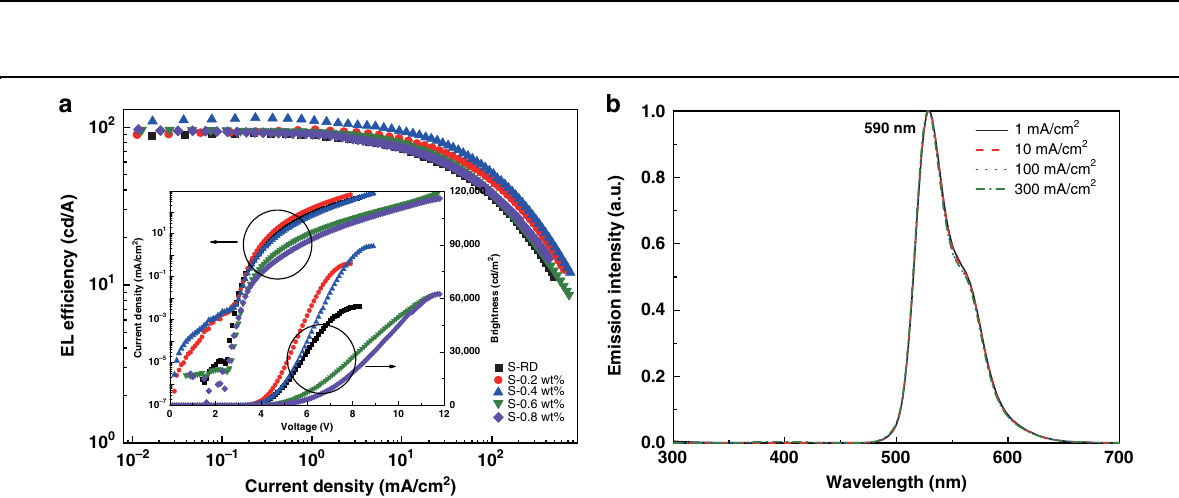
Fig. 12 The EL characteristics of Ir(tfmppy) 2 (tpip based devices at different co-doped concentrations. a Ef fi ciency – current density ( η – J ) characteristics. Insert: current density – brightness – voltage ( J – B – V ) characteristics. b Normalized EL spectra. Reprinted from [89], with permission